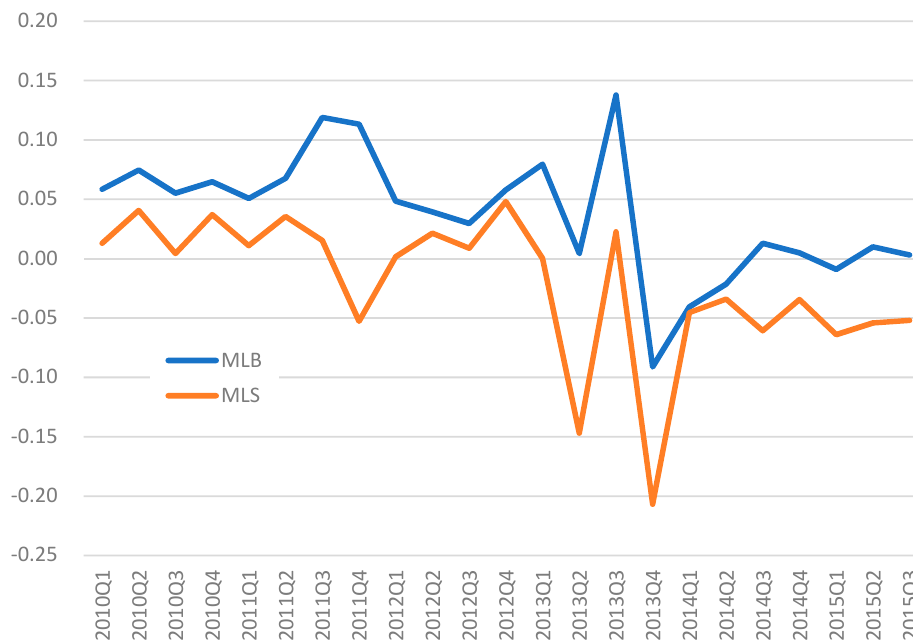
Figure 3. Temporal Changes of Price Differentials for Non-local Buyers and Sellers. Notes: The chart illustrates the coefficients estimated by Model (3) of the interactive terms between time and non-local buyers MLB (𝜏 (cid:3047)(cid:3029) + 𝛽 (cid:2869) ) as well as the interactive terms between time and non-local sellers MLS (𝜏 (cid:3047)(cid:3046) + 𝛽 (cid:2870) ) . The results vividly indicate that non-local price premia are changed into a non-local discount after the non-local specific stamp duties are introduced in circa 2012/13.